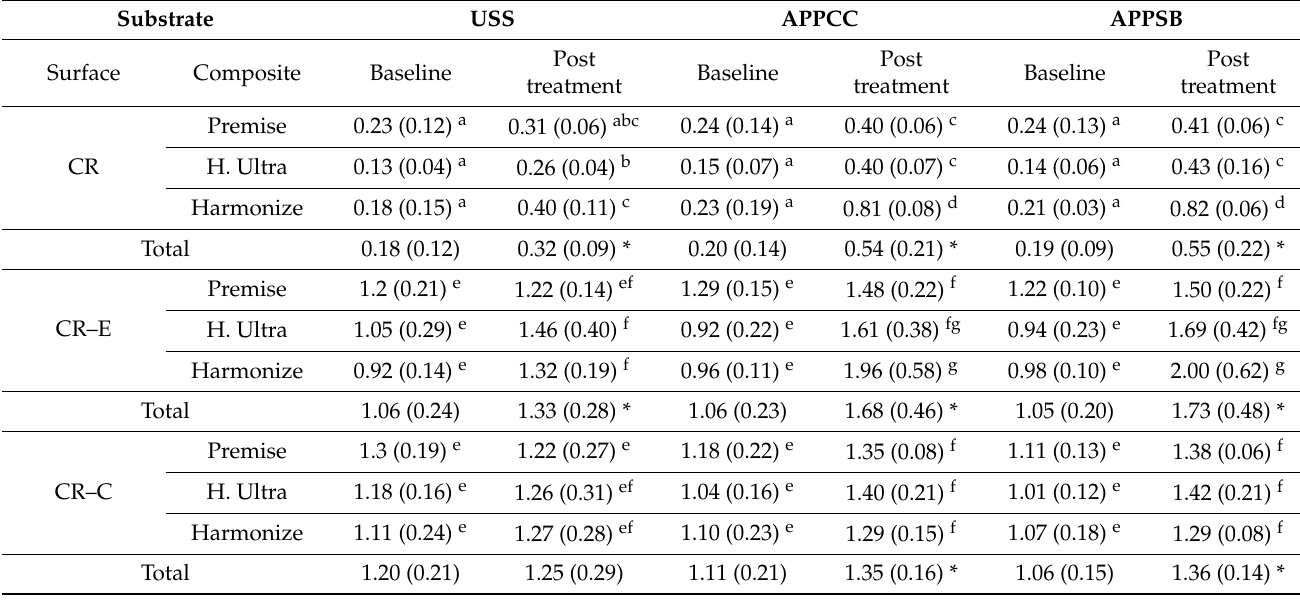
Table 2. Mean Ra values ( µ m) of the composite surface and composite/enamel and composite/cementum interfaces before and after hygiene maintenance procedures, M ( σ ).